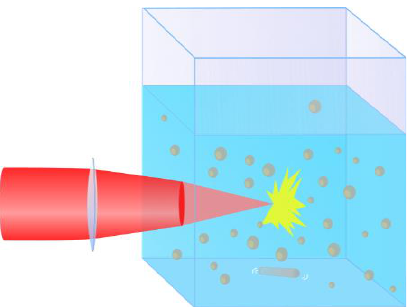
Figure 3. Schematic representation of the fragmentation geometry.